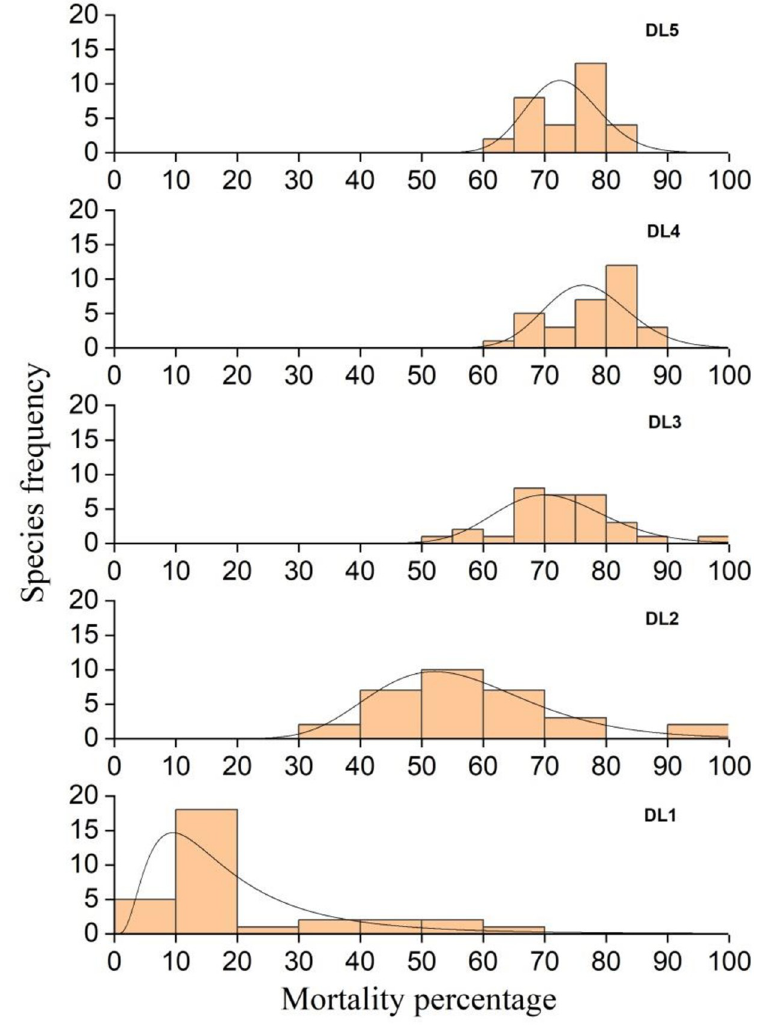
Fig 2. Distribution of acridid species based on mortality percentage (M%) at different density levels (DL1 to DL5). Each bar represents the number of species (Y-axis) that displayed a specific M% (X-axis). Therefore, the sum of all bars for a DL represents the total number of acridid species (n = 31). Shifting bars from lower to higher mortality scales indicates that species tend more vulnerable to death as DL